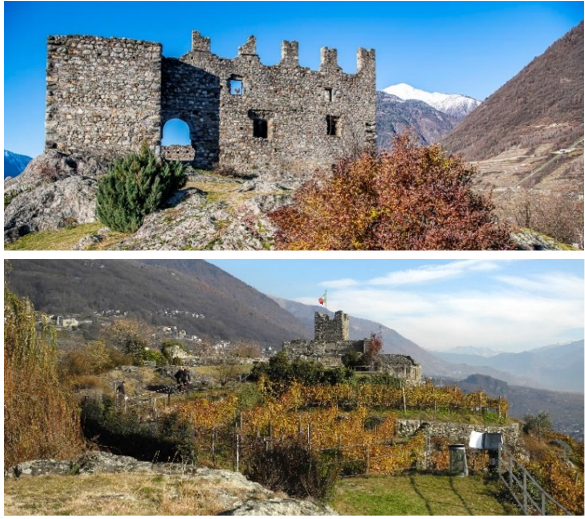
Figure 2: The case study used to try out the proposed method, Castel Grumello in Valtellina